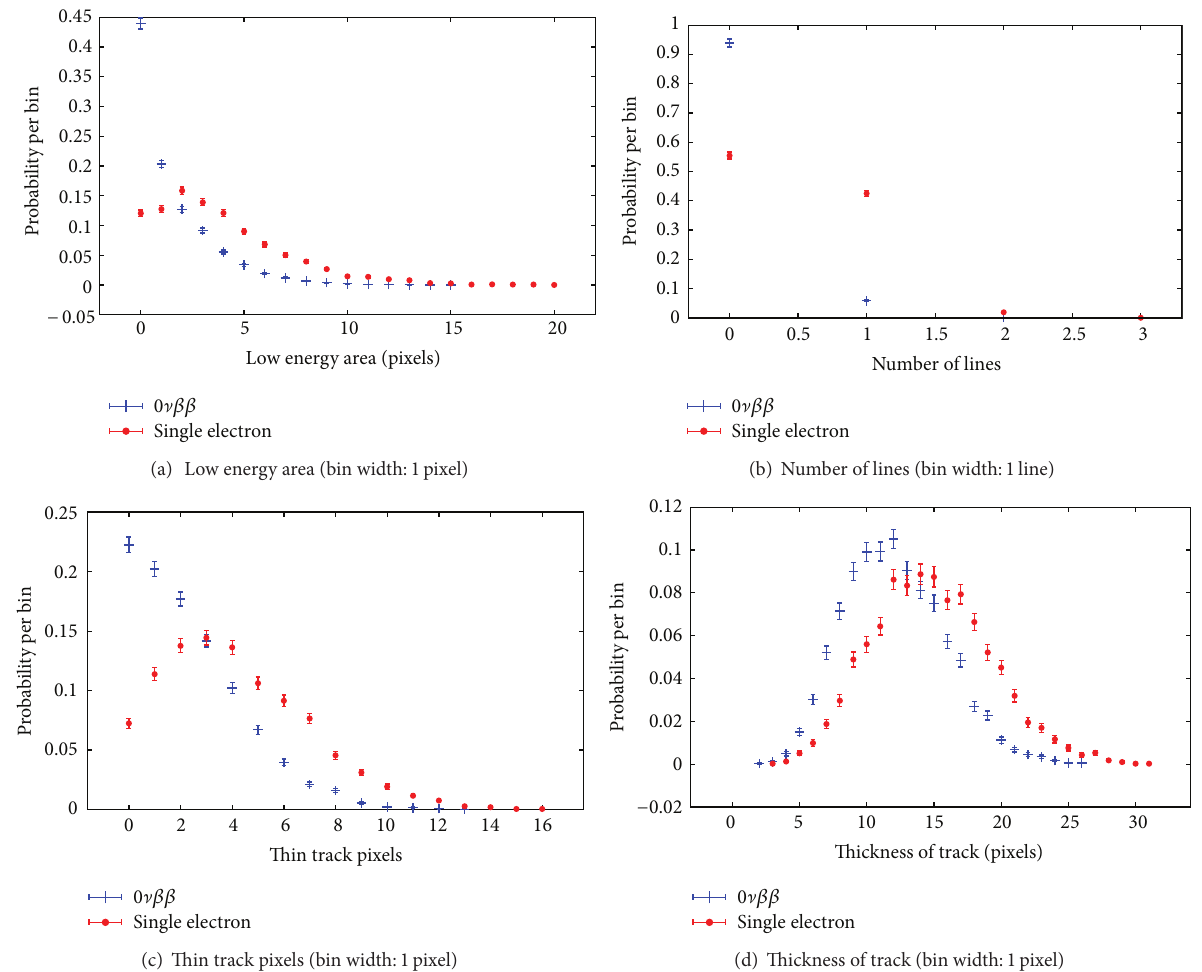
Figure13:Probabilitiesperbinfortheoccurrenceoffeaturevaluesinaneventfor 0 ] 𝛽𝛽 -decaysandforsingleelectronswithenergydeposition around 𝐸 𝑄 for a 3 mm thick CdTe sensor with 110 𝜇 m pixel pitch. The bin width is given in the caption of each feature.